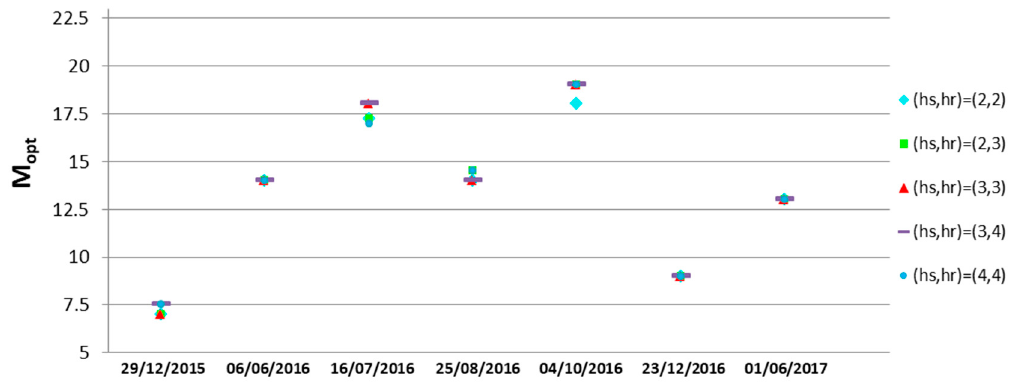
Figure 6. Estimated median of selected segments’ optimal thresholds M opt for 7 dates and 5 sets 6. of mean-shift segmentation parameters ( h s and h r are the segmentation spatial radius and the segmentation feature space radius, respectively).